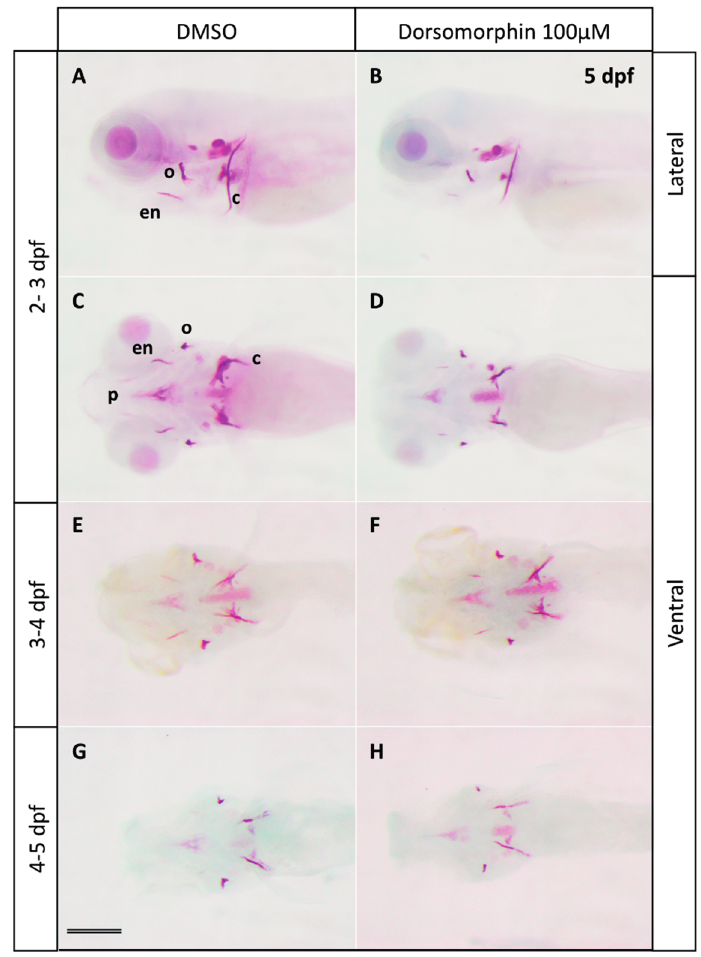
Figure 1. Effects of the BMP inhibitor dorsomorphin on bone mineralization. Alizarin